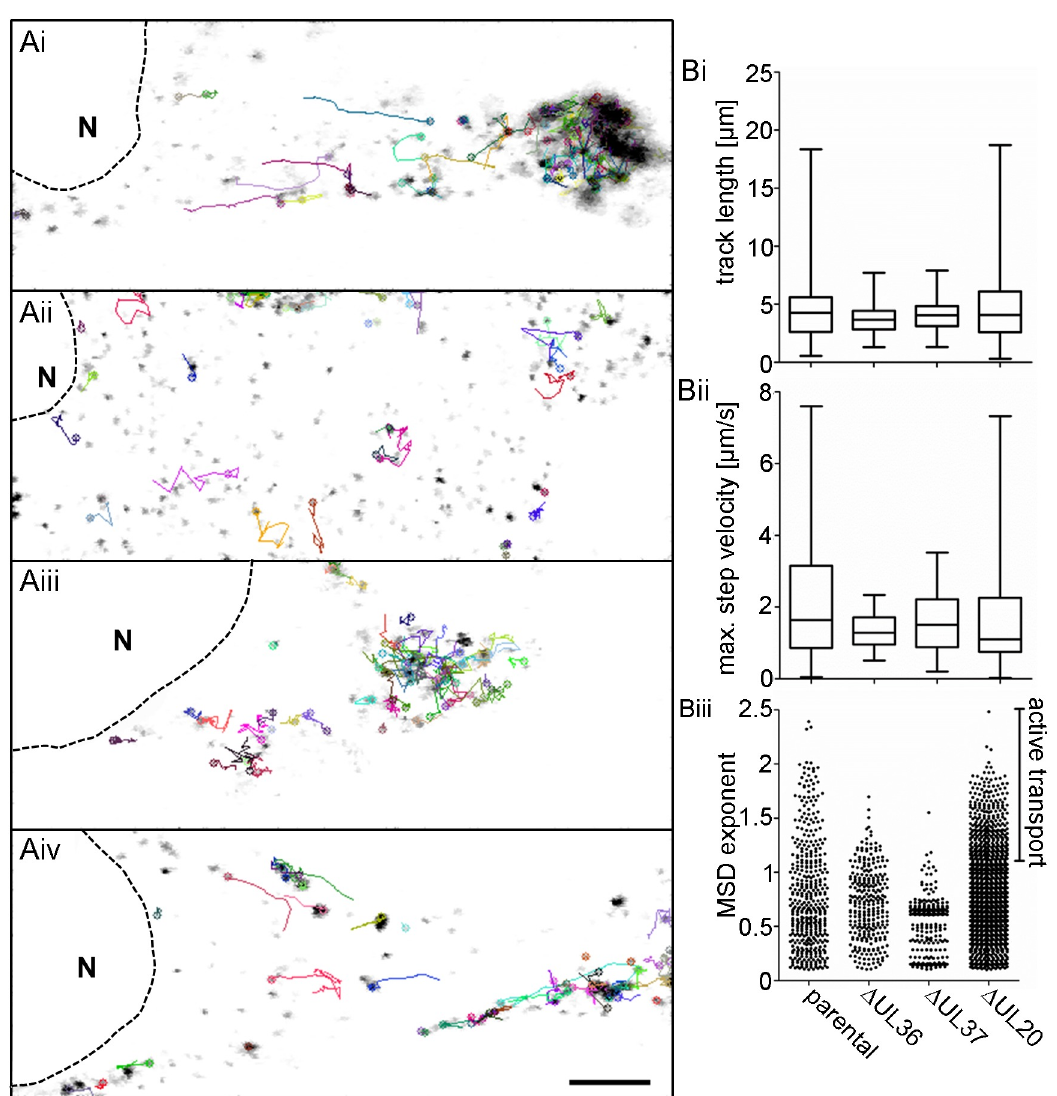
Fig 4. HSV1-pUL20 is not required for directed intracellular transport in epithelial cells. Vero cells were infected with 6.4 x 10 6 pfu/ml (10 pfu/cell) of HSV1(17 + )Lox-mCheVP26 (Ai), - Δ UL36(Aii), - Δ UL37(Aiii), or - Δ UL20(Aiv) and movies were acquiredat 8–10 hpi. (A) Stills of movies in Vero cells (S1–S4Movies) and with representative track profiles (indicatedby a colored line and the front of each track marked by an open circle). Scale bar, 5 μ m. (B) Analysis of track profiles of HSV1(17 + )Lox-mCheVP26 (parental), - Δ UL36,- Δ UL37, or – Δ UL20.(Bi) Track length and (Bii) maximum step velocity of tracks with a MSD ex (cid:21) 1.2, (Biii) mean square displacement exponent(MSD ex ), with each dot representingone track. Box and whiskerswith min and